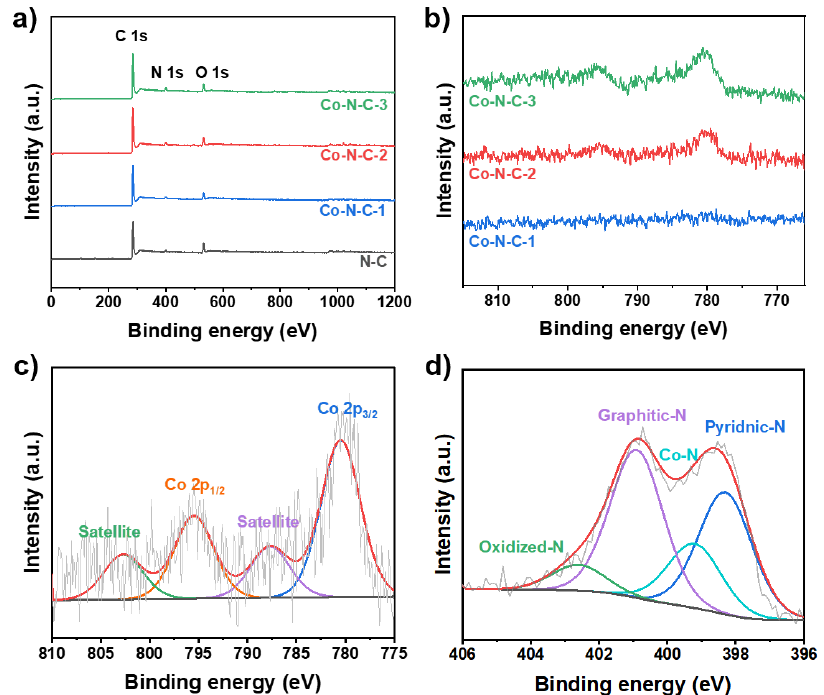
Figure 4. ( a ) XPS survey spectra of the N-C and Co-N-C catalysts; ( b ) Co 2p spectra of the Co-N-C catalysts; ( c ) Co 2p peaks and the fitting result of the Co-N-C-2; ( d ) N 1s peaks and the fitting result of the Co-N-C-2.